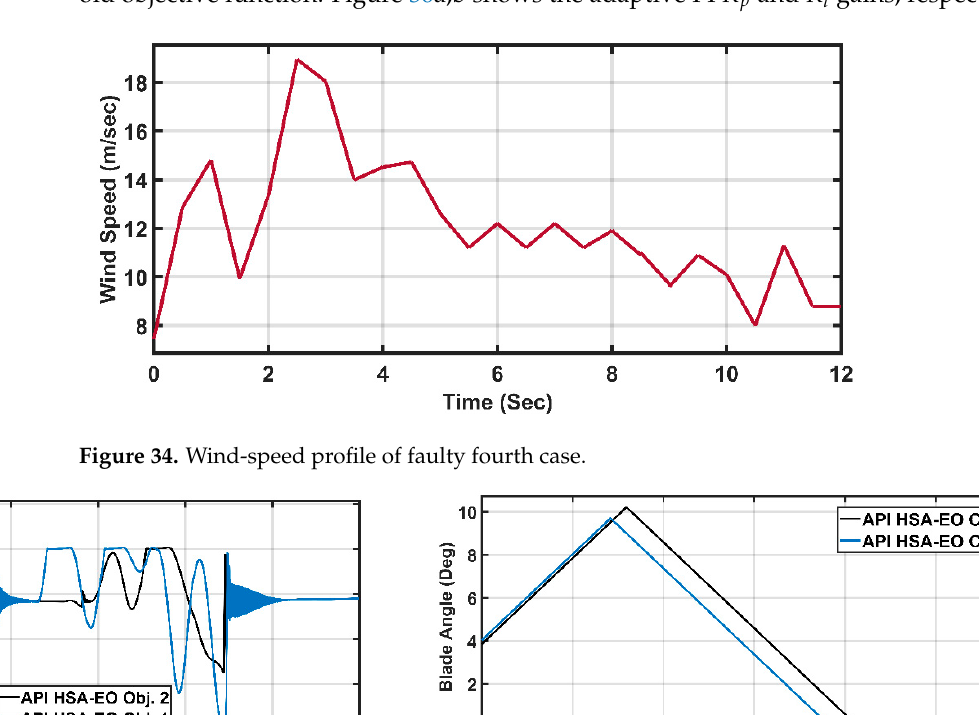
Table 17. Numerical comparison between the controllers at faulty fourth case.